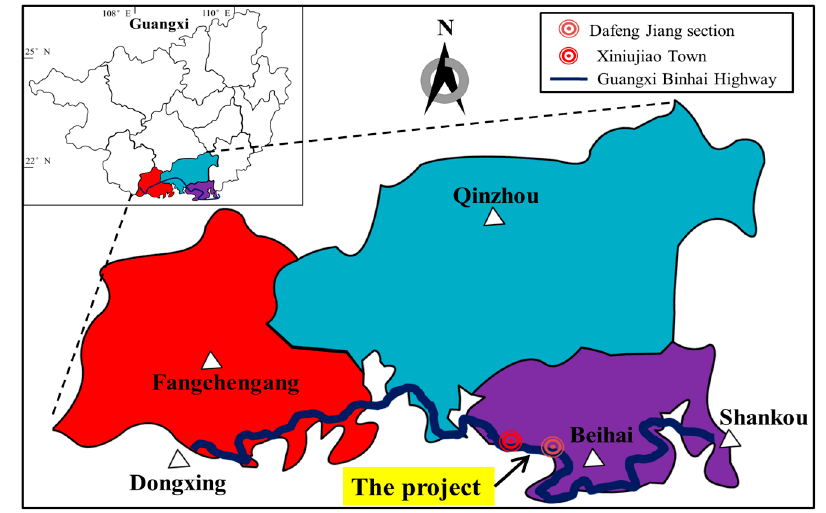
Figure 6. Relying on the engineering location map.